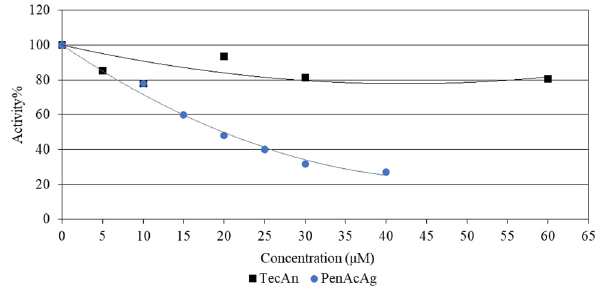
Figure 12: LOX activity ( A % ) vs various concentrations of TecAn and PenAcAg .